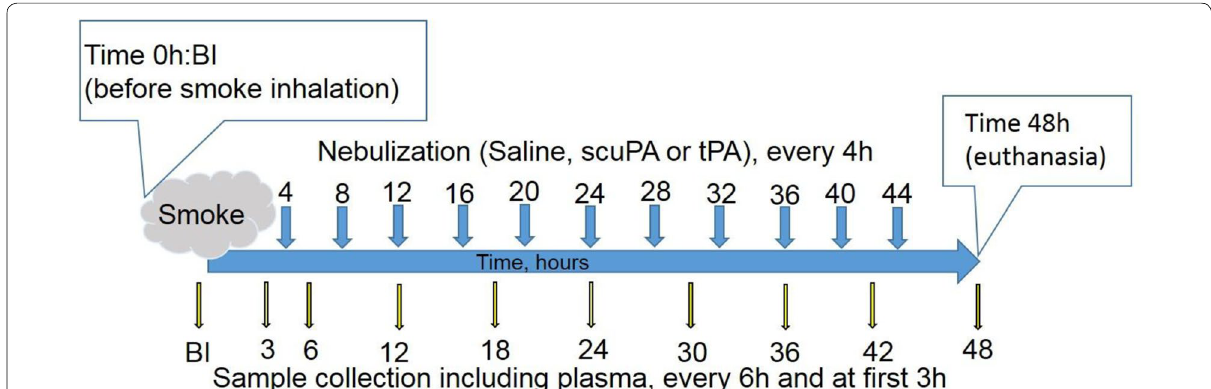
Fig. 1 Schematic illustration of the treatment schedule and sample collection protocol. The long blue horizontal arrow defines the 48 h treatment period. The short blue arrows indicate treatment intervals after initiation of ISIALI, which was achieved by the inhalation of 48 successive puffs of cooled cotton smoke, indicated by the smoke cloud depiction. The longer yellow arrows with black borders indicate plasma collection times. BI before